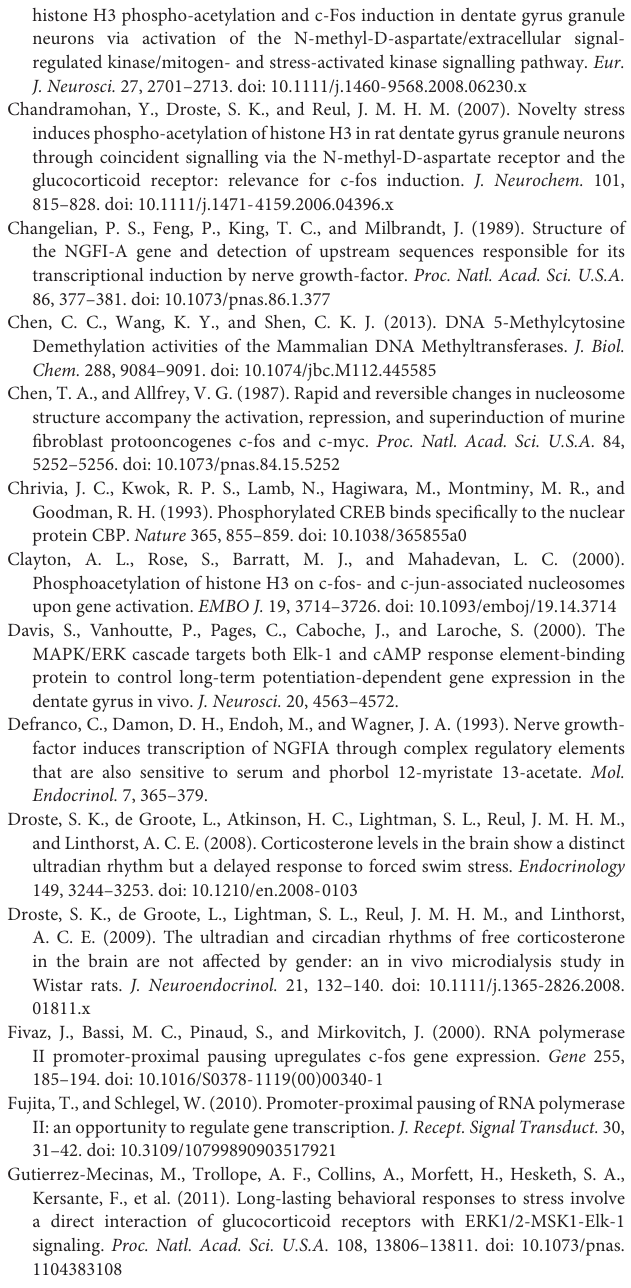
FIGURE S4 | pCREB binding within the rat hippocampal Bdnf gene. Rats were killed either under baseline conditions or 5 or 15 min after the start of FS (25 ◦ C water). Chromatin immuno-precipitation was carried out on whole hippocampal tissue using antibodies against pCREB. Primers for qPCR were designed covering a predicted CRE located near the transcriptional start site for exon IXa within the Bdnf gene. The graph shows enrichment of pCREB at the bdnf CRE site. The enrichment for each group was calculated by dividing the quantity of target DNA in the bound fraction by the quantity of DNA in the input fraction (ratio bound over input, B/I), as determined by qPCR analyses (see section “Materials and Methods”) [mean ± SEM, n = 4]. Statistical analysis: One-way ANOVA; F ( 2 , 9 ) = 8.066, p = 0.0098; Bonferroni post hoc test: ∗∗ p < 0.01 compared with the BL